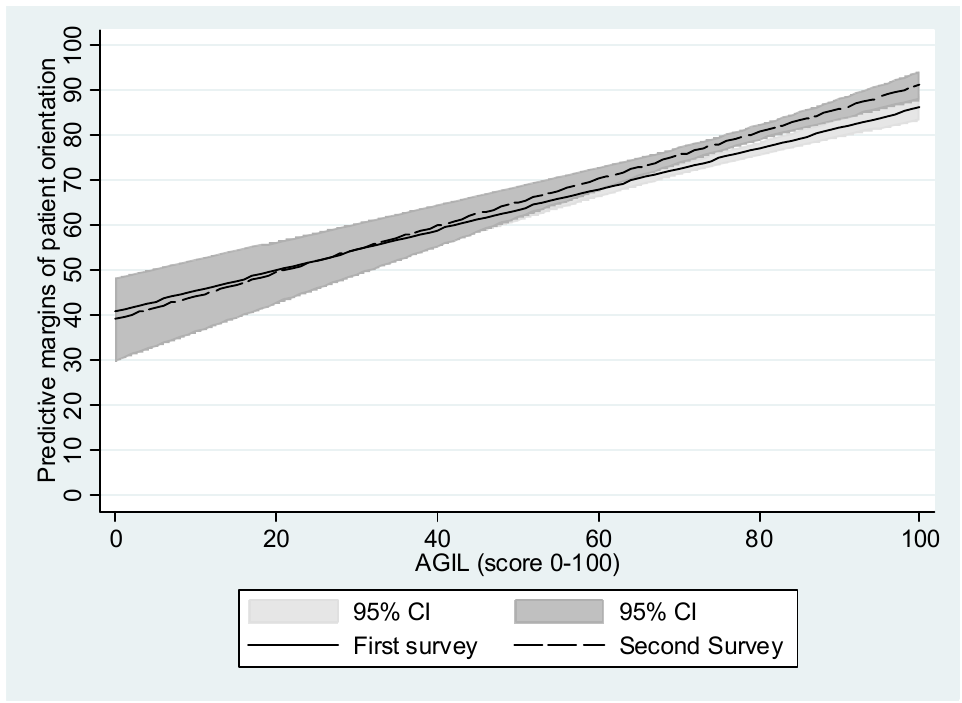
Figure 2. Association between perceived person-centered care (“patient orientation”) and AGIL scores by survey cycle .